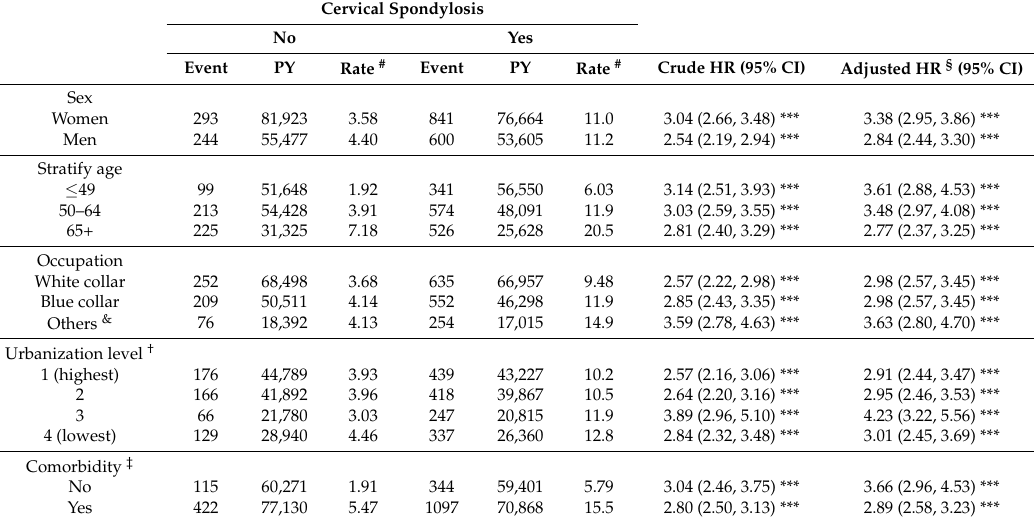
Table 3. Comparison of incidence densities of Arrhythmia and Cox model measured hazard ratio between patients with and without cervical spondylosis by demographic characteristics and